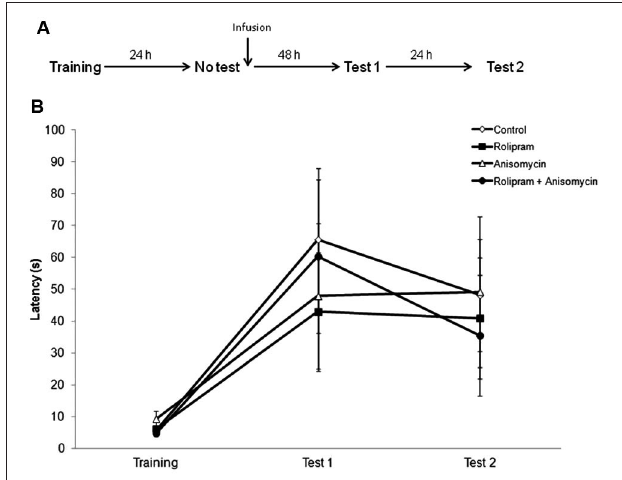
FIGURE 3 | Delayed infusion control . Rats were given an IA training trial followed 24 h later by a retrieval/extinction session (Test 1). 1 h after Test 1, animals were infused into the dorsal hippocampus with vehicle or rolipram (7.5 µ g/side, N = 8 rats per group). Retention test trials were carried out 48 (Test 2) and 72 h (Test 3) later. (A) Schematic diagram showing the experimental design. (B) Latencies to step-down during IA behavioral trials. There were no significant differences among groups.